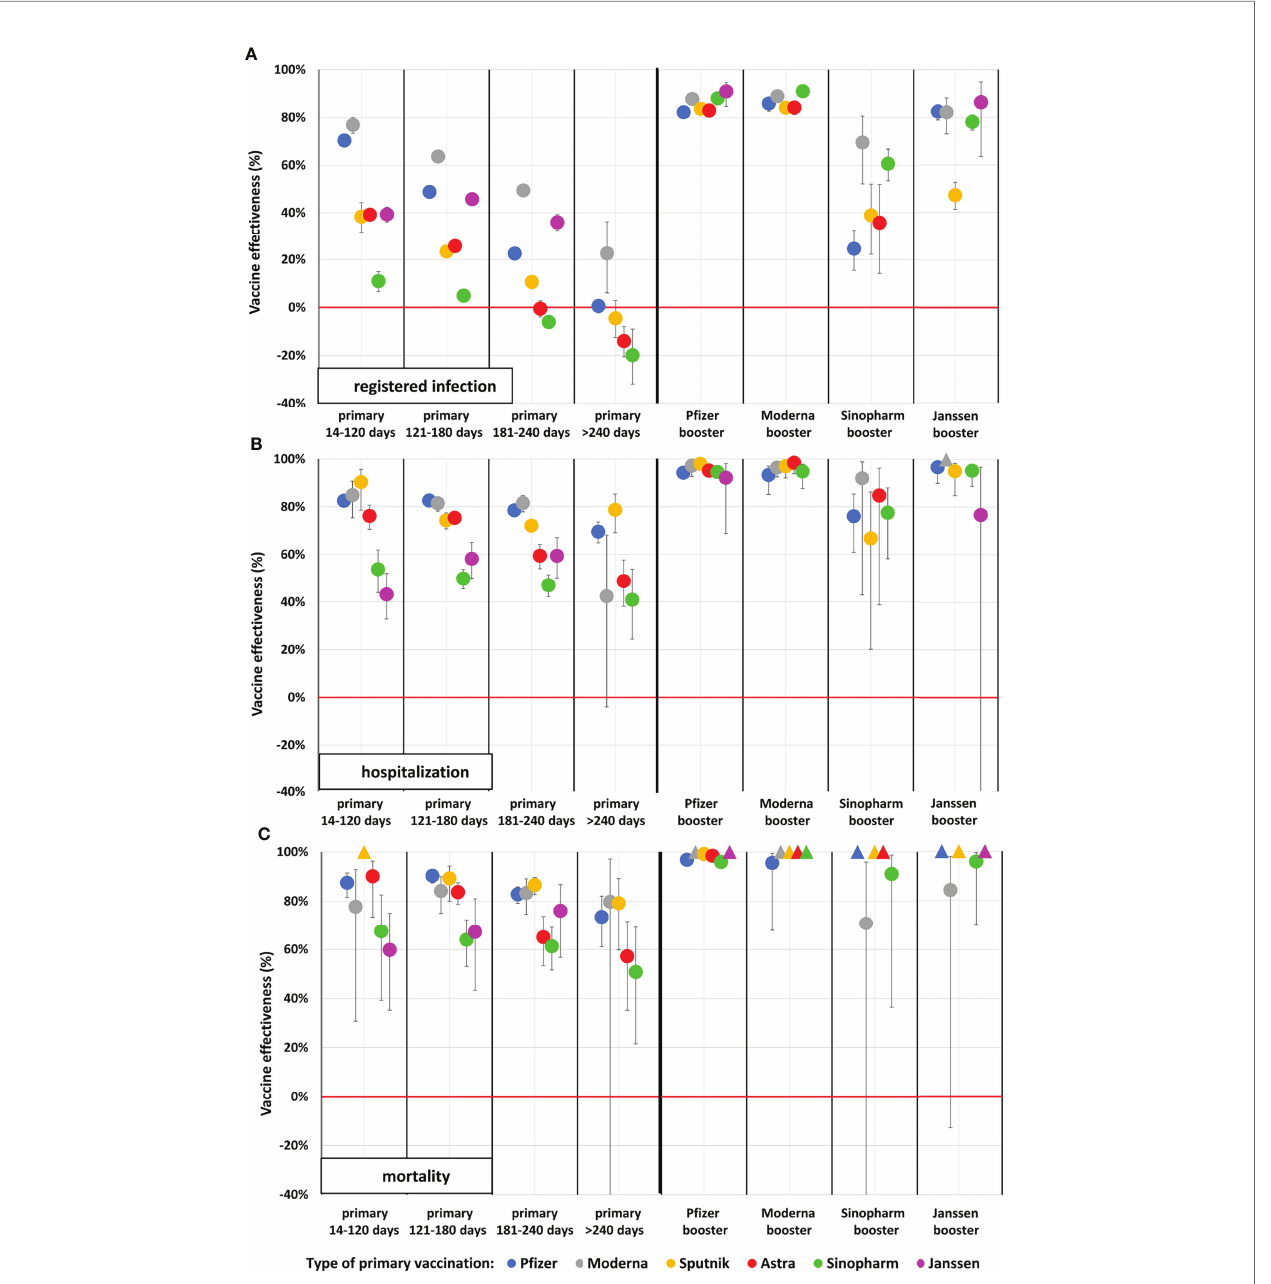
FIGURE 1 | Adjusted vaccine effectiveness against registered SARS-CoV-2 infection, Covid-19 related hospitalization and death during the Delta wave in the Hungarian population aged 16 – 64 years. (Data points marked with triangles at value 100% indicate vaccine combination categories where no outcome occurred. In these categories, the person-time of observation is very limited). (A) Registered infection, (B) Hospitalization, (C)